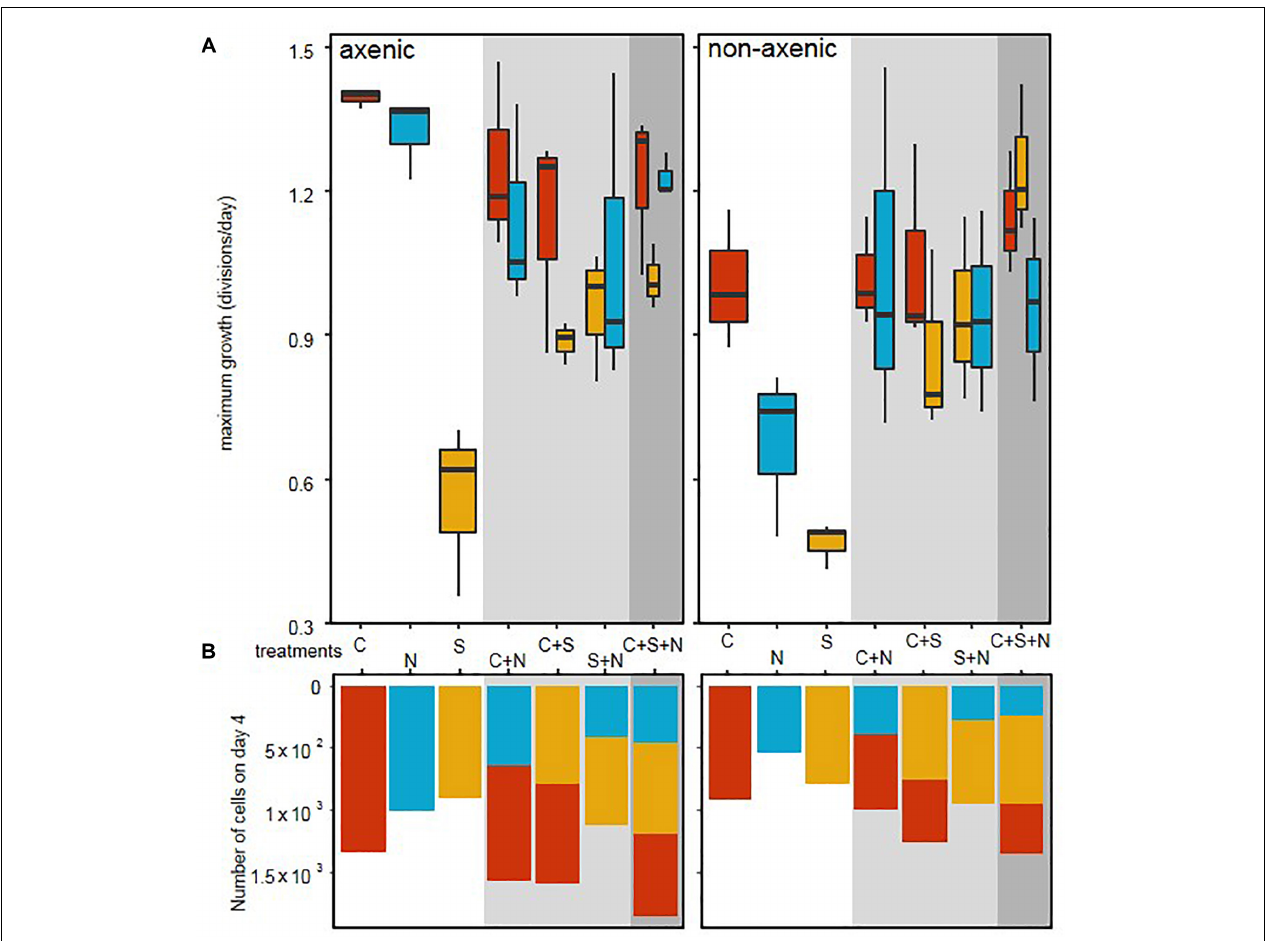
FIGURE 1 | Bacteria cause a shift in diatom growth rates. (A) Maximum growth rates, derived from daily cell counts for three different diatom species: C. closterium ([C], red), N. phyllepta ([N], blue), and S. robusta ([S], yellow) in the presence (non-axenic) or absence (axenic) of bacteria. The white, gray and dark gray background, respectively show diatoms grown either in monocultures, diatom pairs or the three diatom-species combined. (B) The number of diatom cells per well on the fourth and last day are shown using the same color code as